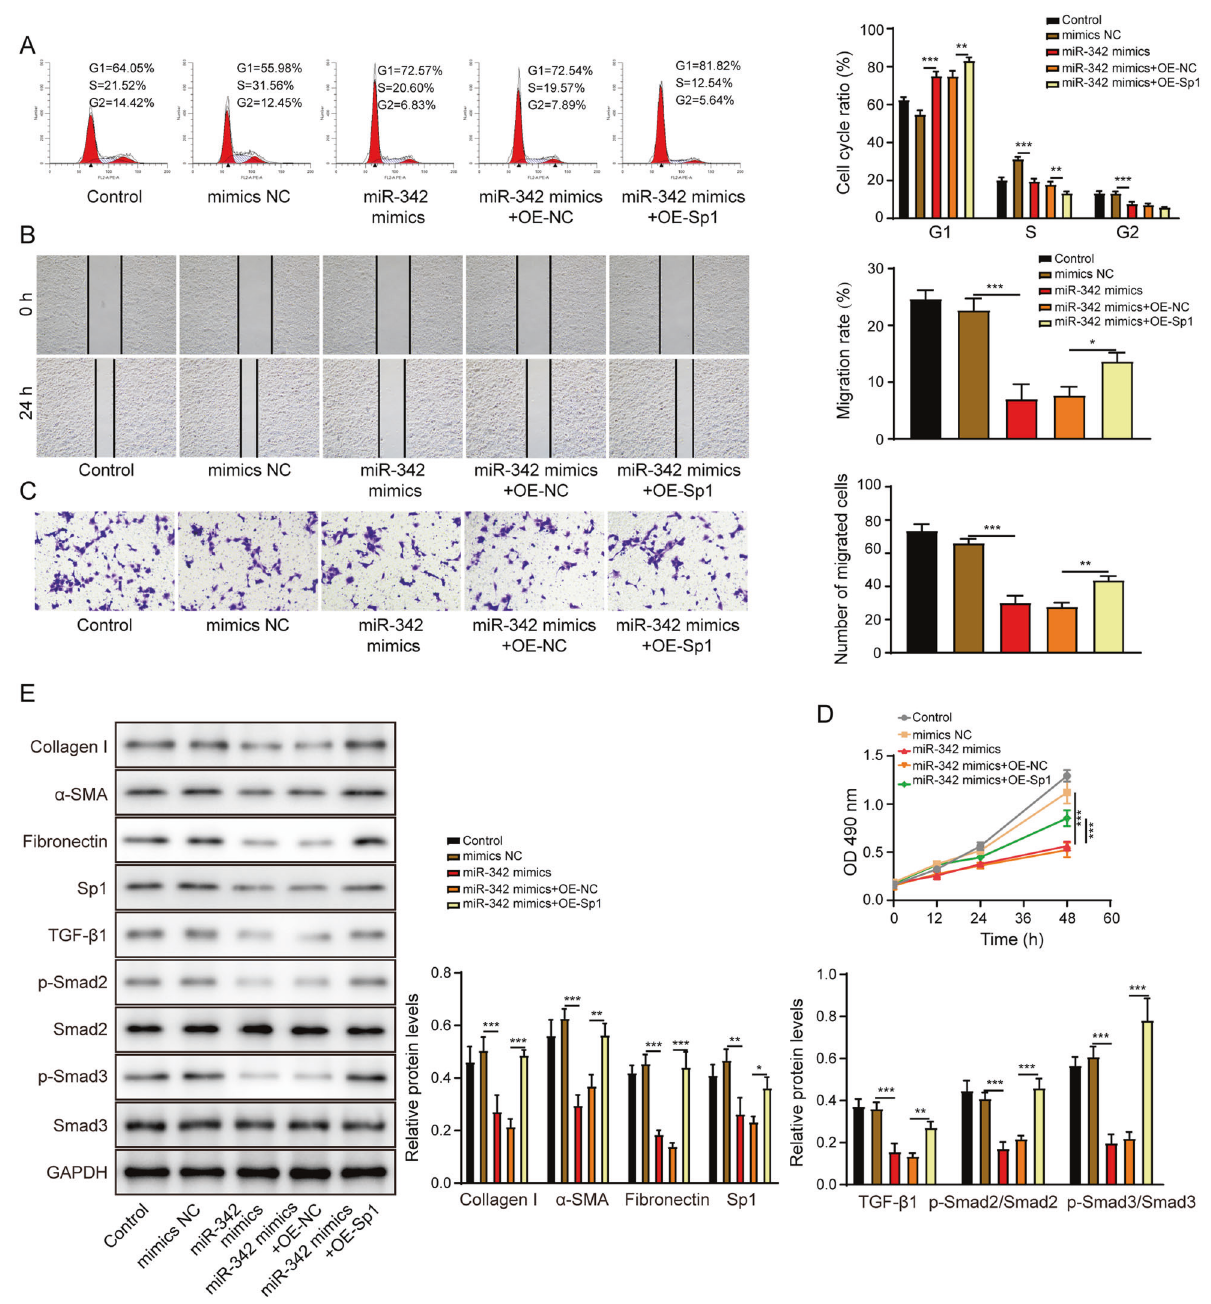
Fig. 8 MiR-342 suppresses HSCs activation by negatively mediating Sp1. A The cell cycle of the LX-2 was examined by the fl ow cytometry. B , C The migration of LX-2 was determined by the scratch assay ( B ) and the transwell assay ( C ). D The LX-2 cell proliferation was examined by the CCK-8 assay. E The protein levels of collagen I, α -SMA, fi bronectin, Sp1, TGF- β 1, p-Smad2, Smad2, p-Smad3, and Smad3 were measured by western blot. * p < 0.05; ** p < 0.01; *** p <